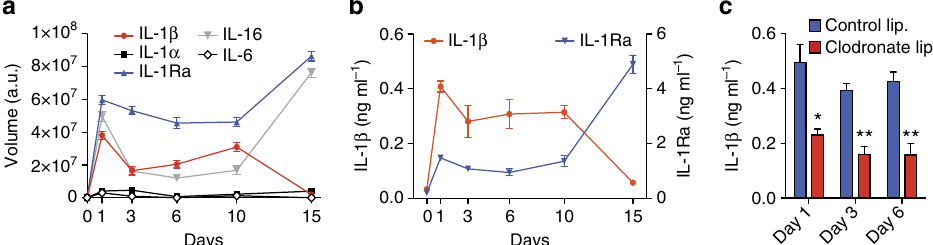
Figure 2 | IL-1 b is present at a significant concentration in bone defects within the first 10 days following injury. ( a – c ) Calvarial defects (4mm diameter) were treated with fibrin matrices. Fibrin matrices and bone tissue surrounding the defects (1mm farther) were collected at different time points. Interleukins present in the harvested tissues and in fibrin matrices were detected using an antibody array ( a ) and by enzyme-linked immunosorbent assay ( b , c ). ( c ) IL-1 b concentrations found in mice that have been treated with control or clodronate liposomes (lip.). For panels a – c , data are means ± s.e.m. ( n Z 3 per time point). * P o 0.05, ** P o 0.01; Student’s t -test.